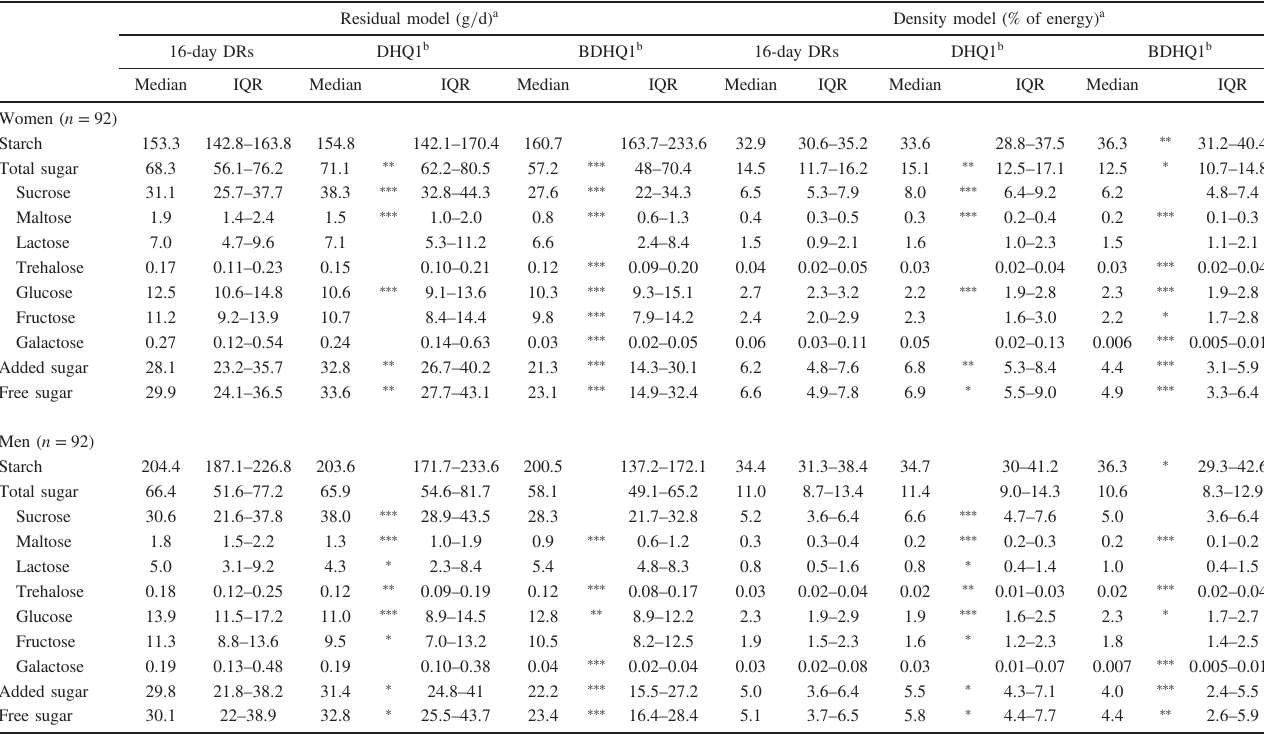
Table 3. Intake of starch and 10 types of sugars estimated using the 16-day DRs, DHQ1, and BDHQ1 among Japanese women and